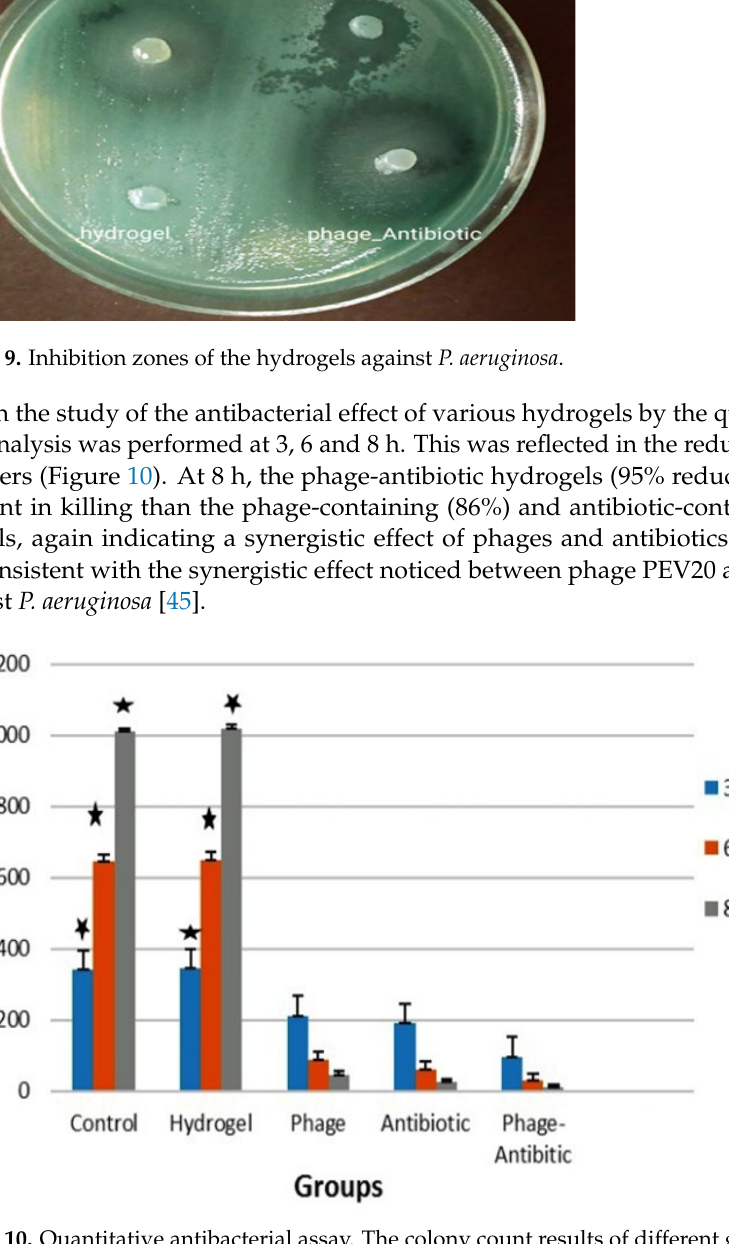
Figure 10. Quantitati ve antibacterial assay. The colony count results of different groups . The results are based on four repeats showing the average with standard deviations. The statistical